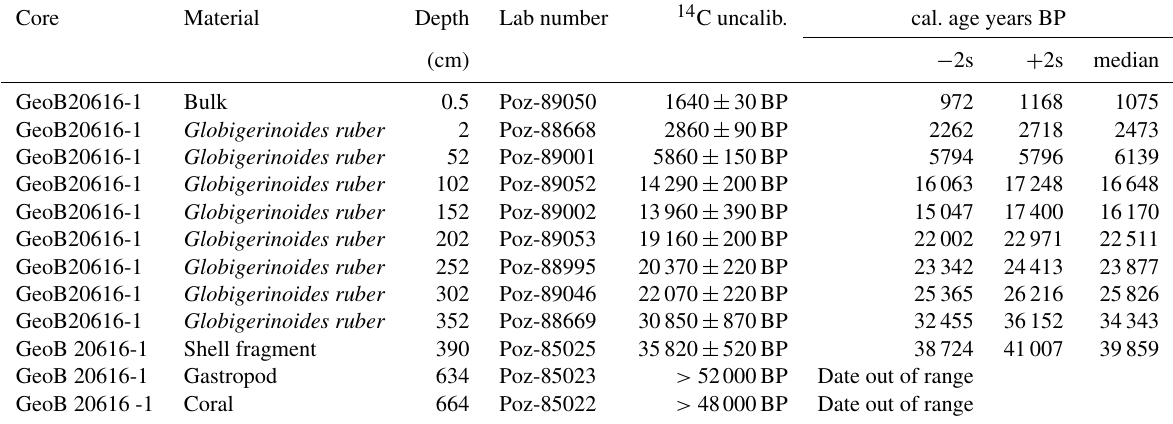
Table 1. AMS radiocarbon analyses of material from core GeoB20616-1. The modeled ocean average curve (Marine13) (Reimer et al., 2013) was used for calibration and a local (cid:49)R of 121 ± 16 per year (Maboya et al., 2017) was applied. The ages were calibrated with Calib 7.1 software (Stuiver et al., 2019). Core Material Depth Lab number 14 C uncalib. cal. age years BP